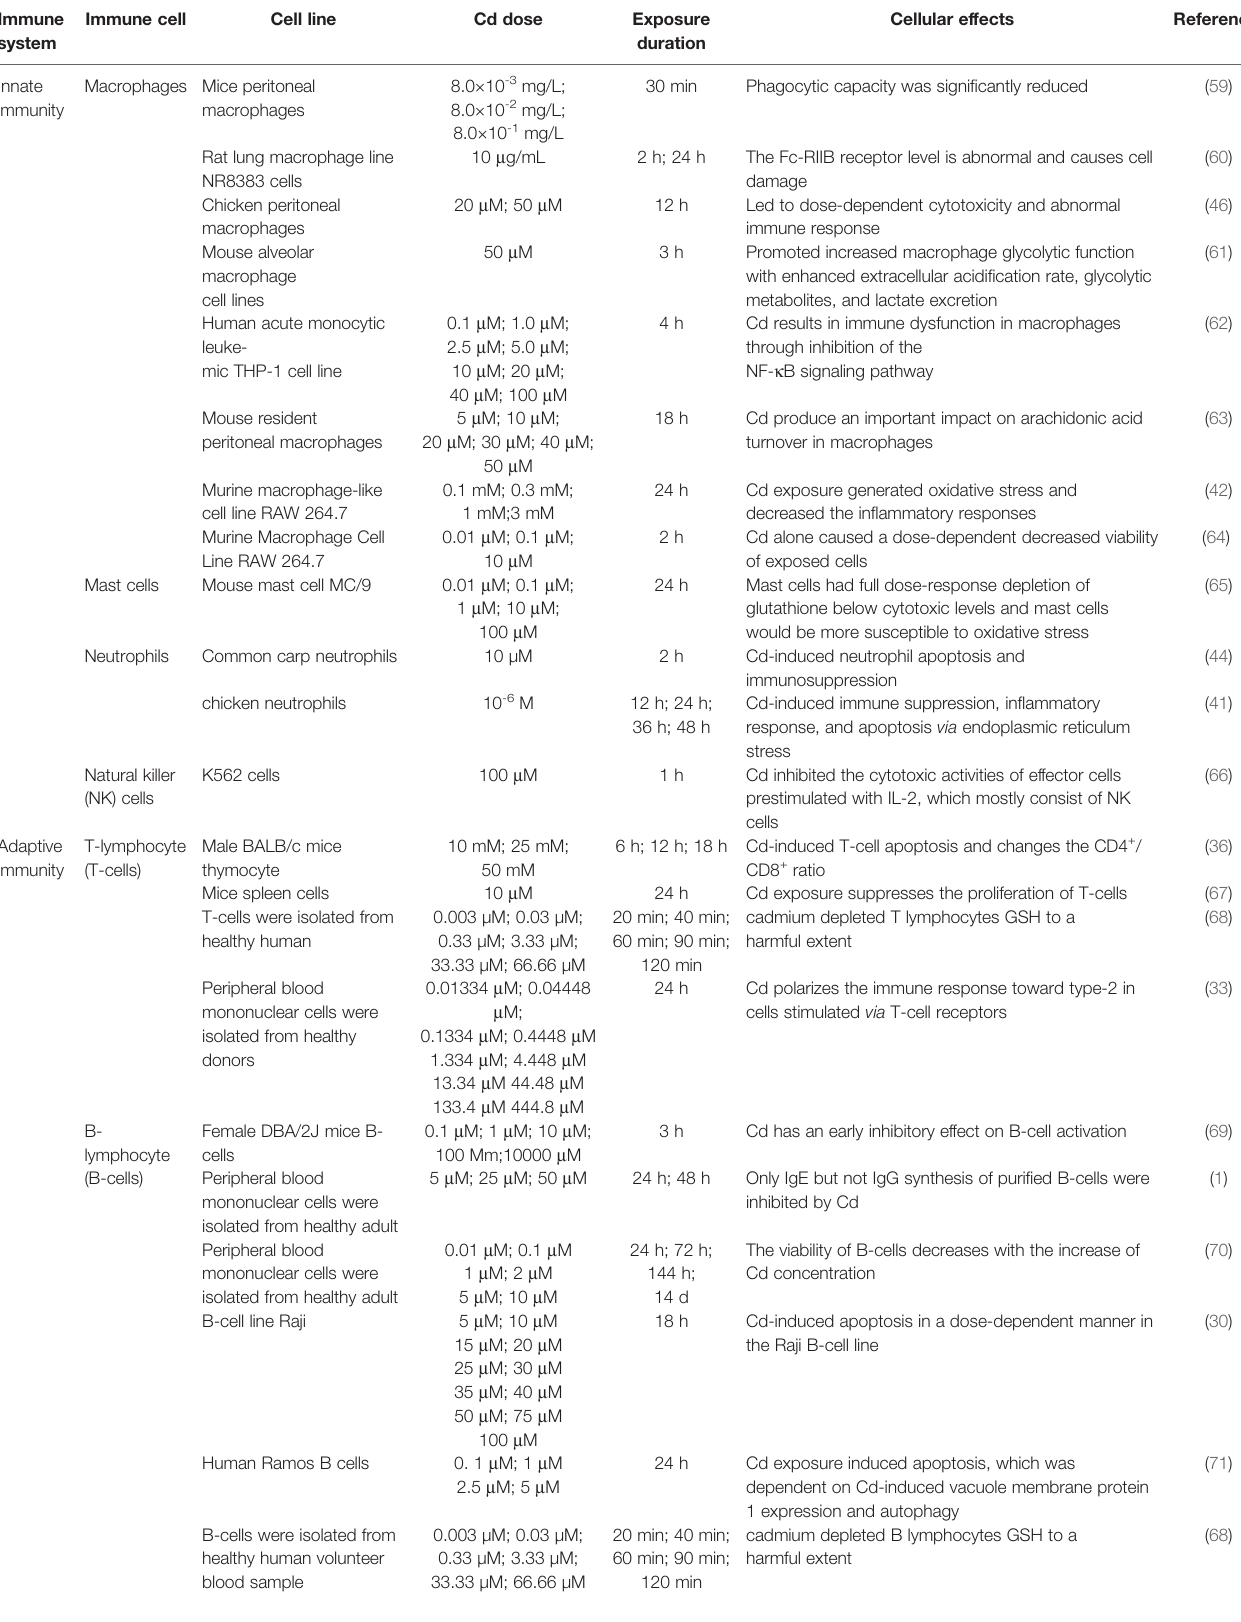
TABLE 1 | Effects of cadmium exposure on immune cells under experimental conditions in vitro